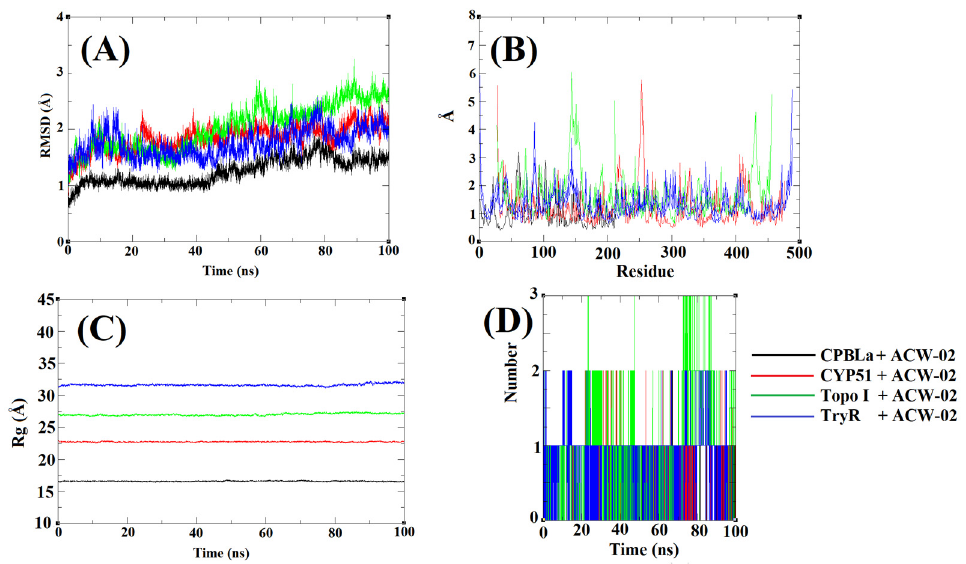
Figure 8. MD simulations plots of ( A ) RMSD; ( B ) RMSF, ( C ) Rg; and ( D ) h-bonds of the CPBLa; CYP51; Topo I and TryR in complex with